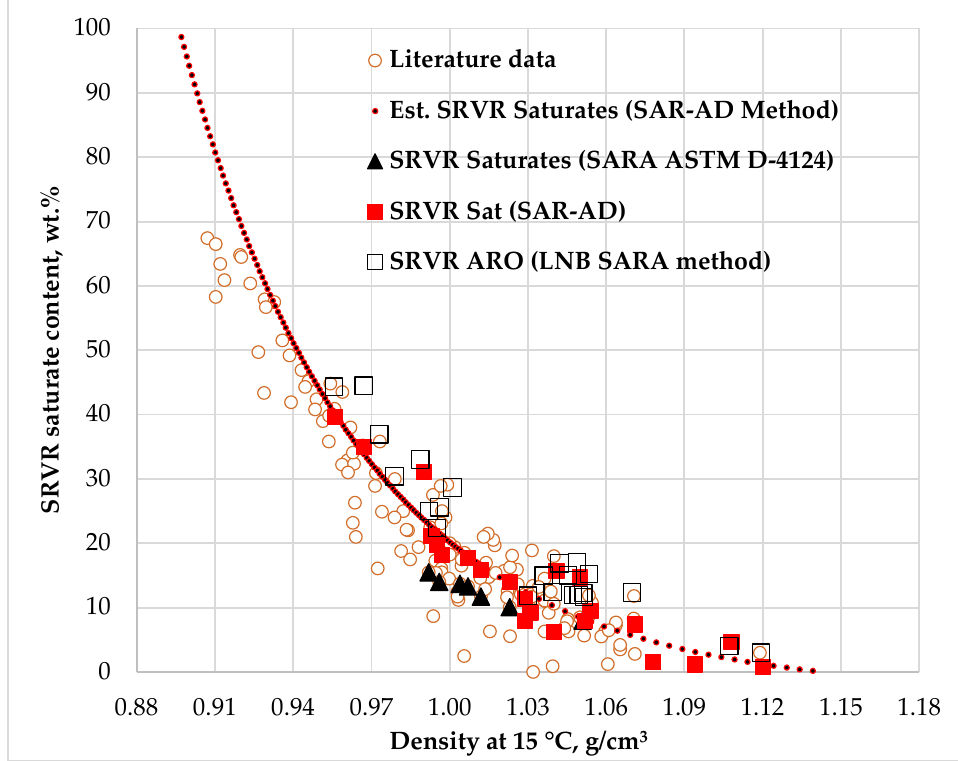
Figure 3. Dependence of saturate content on density of straight run vacuum residues (employing different SARA methods. (Red circle data was extracted from ref. [38])